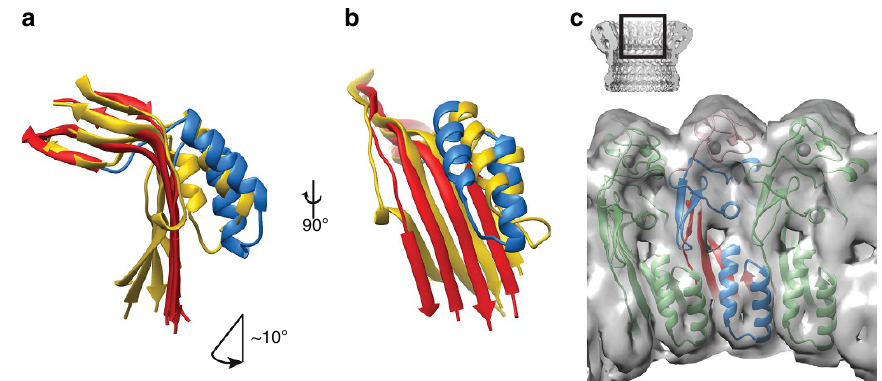
Figure 3 | Comparison between the structure of C6 (PDB ID 3T5O; yellow) and model of poly-C9 (red/blue). The shift of the central bent b -sheet (red) shows ( a ) an B 10 (cid:2) rotation of the bottom half of the sheet together with ( b ) an B 5.5Å lateral movement. ( c ) The HTH region (a pair of a -helices) lines the pore lumen. A trimer is shown with the central monomer coloured red, blue and